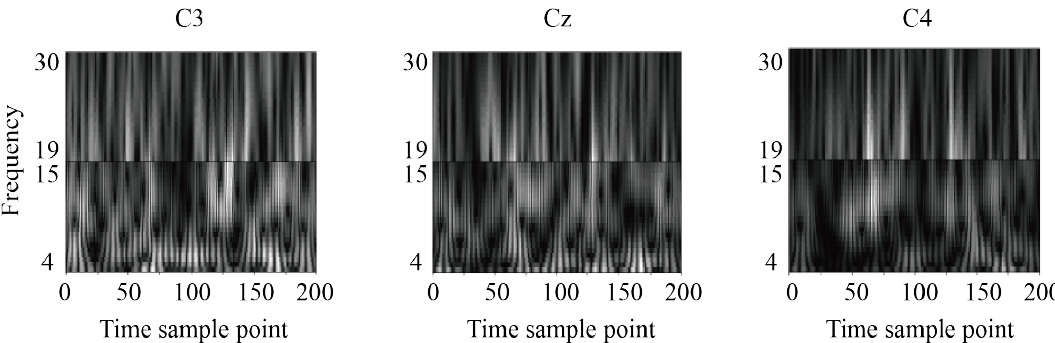
Figure 3. The feature images of the three electrodes (C3, Cz, and C4).